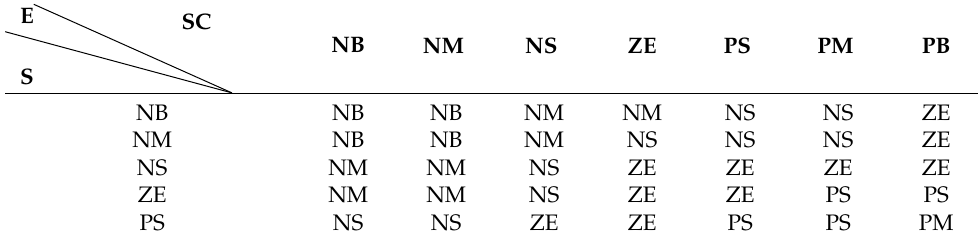
Table 2. Fuzzy control rules.